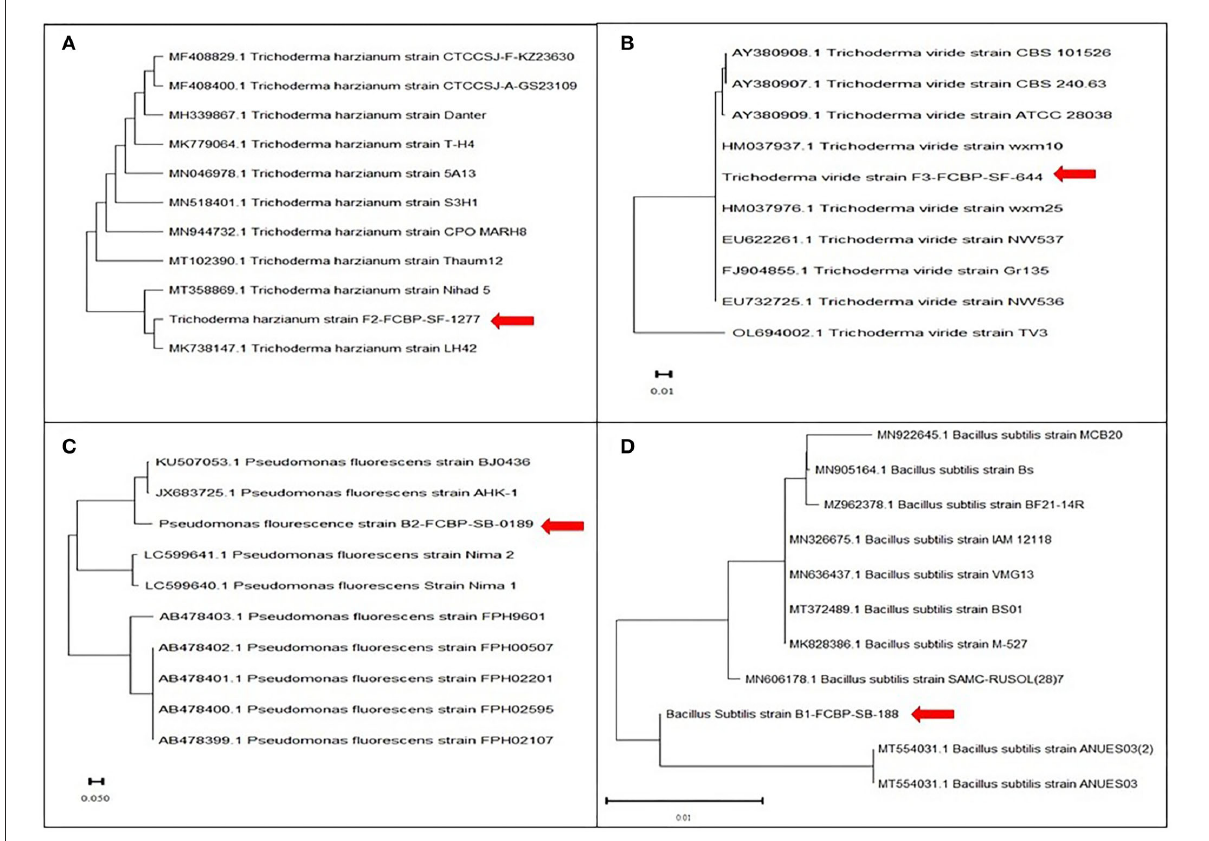
FIGURE2 Phylogenetic dendogram of (A) T. Harzianum, (B) T. viride (sequenced with ITS1 and ITS4 regions), (C) P. fluorescens, and (D) B. subtilis ( sequenced with 16S ribosomal RNA gene) for identification using sanger sequencing. Phylogenetic tree was constructed using the